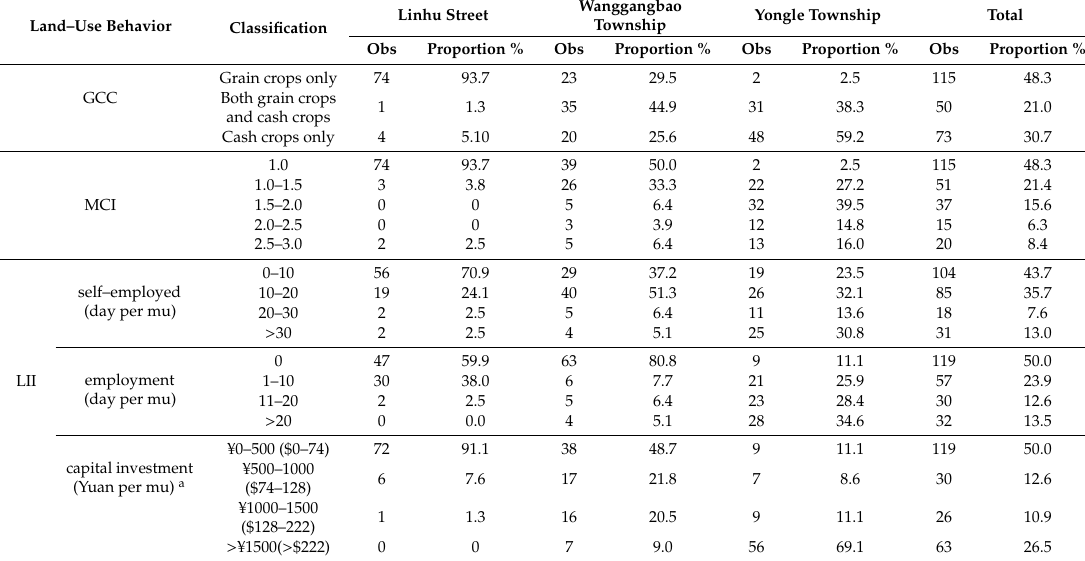
Table 3. Land-use behavior of households in the study